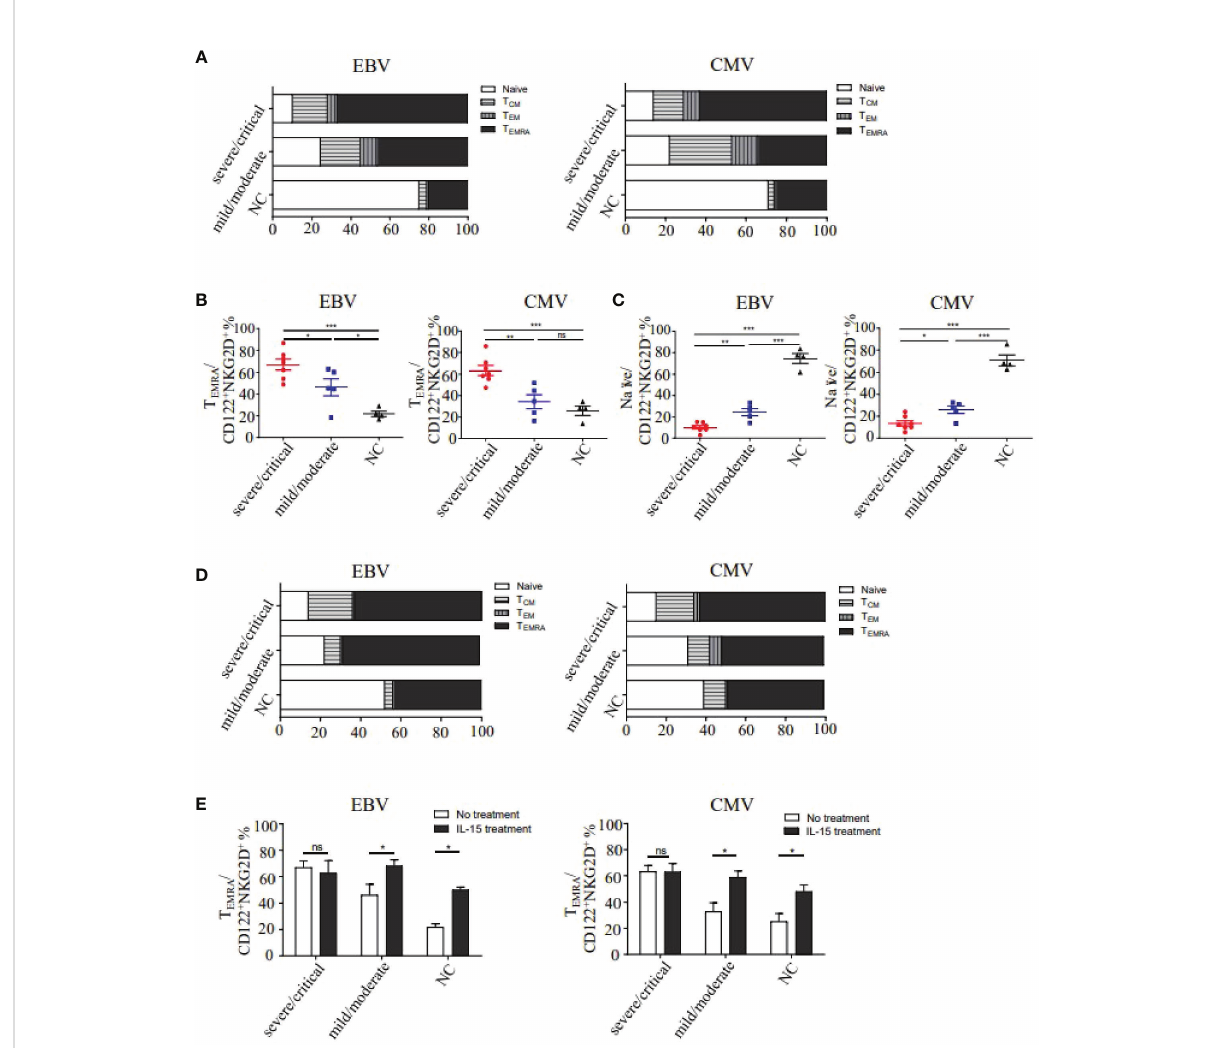
FIGURE 5 Analysis of the differentiation phenotypes of CD122 + NKG2D + EBV or CMV p/HLA-A*02 tetramer + CD8 + T cells in HFRS patients. (A) The memory phenotype constitution percentage of naïve (CD45RA + CCR7 + ), effector memory (CD45RA - CCR7 - ), central memory (CD45RA - CCR7 + ) and effector memory-expressing CD45RA (CD45RA + CCR7 - ) of CD122 + NKG2D + EBV or CMV p/HLA-A*02 tetramer + CD8 + T cells in HFRS. (B) Comparison of T EMRA phenotype percentage in CD122 + NKG2D + EBV or CMV p/HLA-A*02 tetramer + CD8 + T cells between different severities of HFRS (n EBV =12, n CMV =12). (C) Comparison of Naïve phenotype percentage in CD122 + NKG2D + EBV or CMV p/HLA-A*02 tetramer + CD8 + T cells between different severities of HFRS (n EBV =12, n CMV =12). (D) The four memory phenotype constitution percentages of CD122 + NKG2D + EBV or CMV p/HLA-A*02 tetramer + CD8 + T cells in HFRS after IL-15 treatment (n EBV =7, n CMV =9). (E) Comparison of the T EMRA percentage of CD122 + NKG2D + EBV or CMV p/HLA-A*02 tetramer + CD8 + T cells in different severities of HFRS with or without IL-15 treatment. *p<0.05; **p<0.01; ***p<0.001; “ ns ” means no signi fi